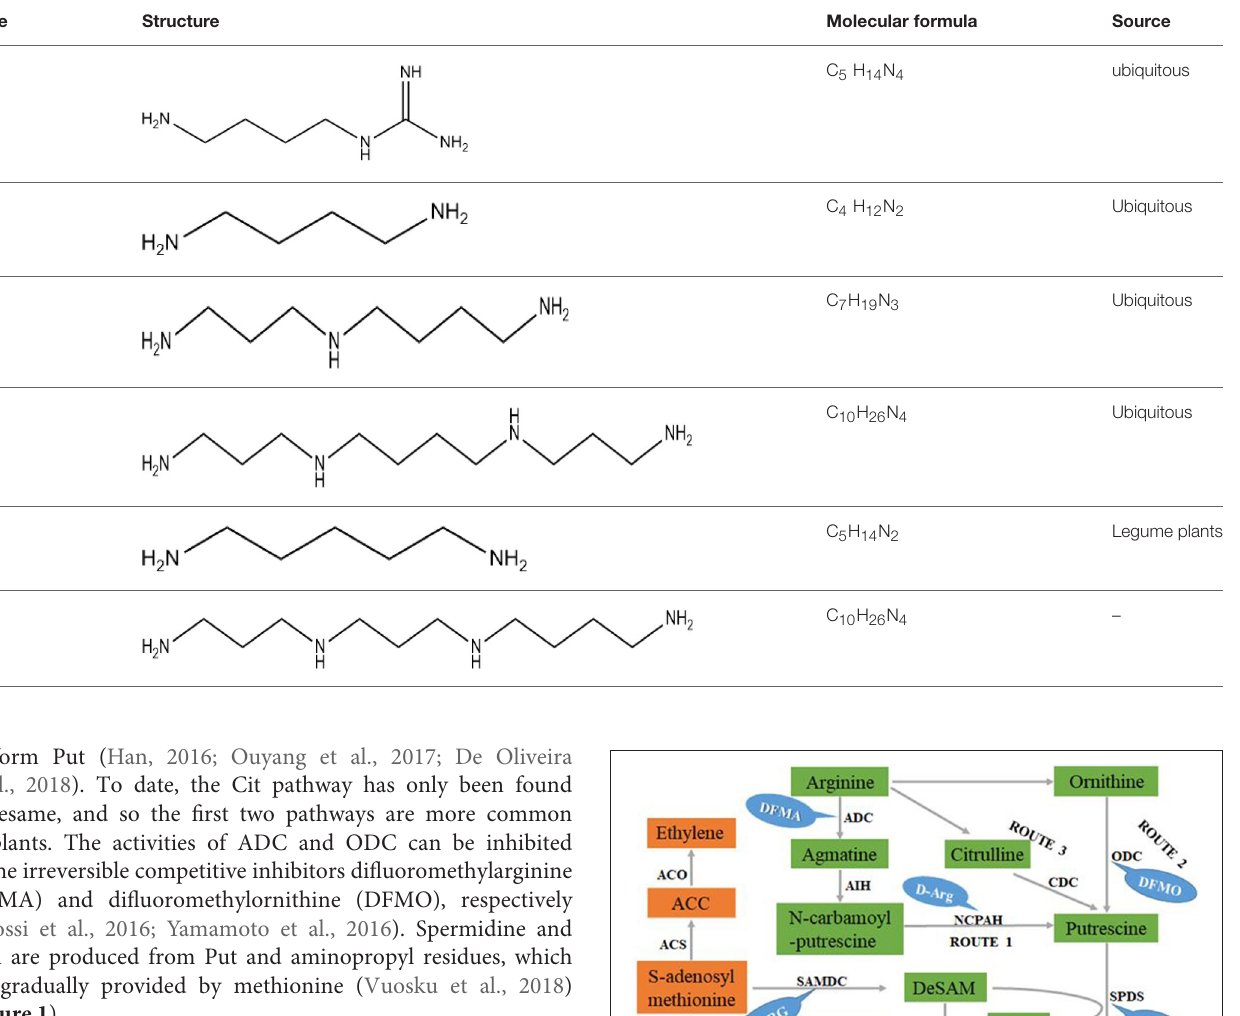
TABLE 1 | Polyamine structure and distribution.